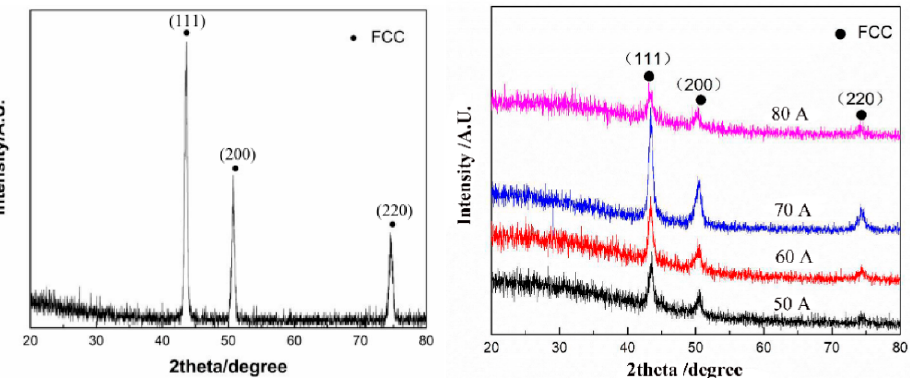
Figure 6. XRD patterns of CoCrFeNiMn HEA powder ( left ) and plasma cladded CoCrFeNiMn HEA coatings ( right ) deposited at plasma arc currents of 50, 60, 70, and 80 A. Reprinted with permission from ref. [13]. Copyright 2021 MDPI.